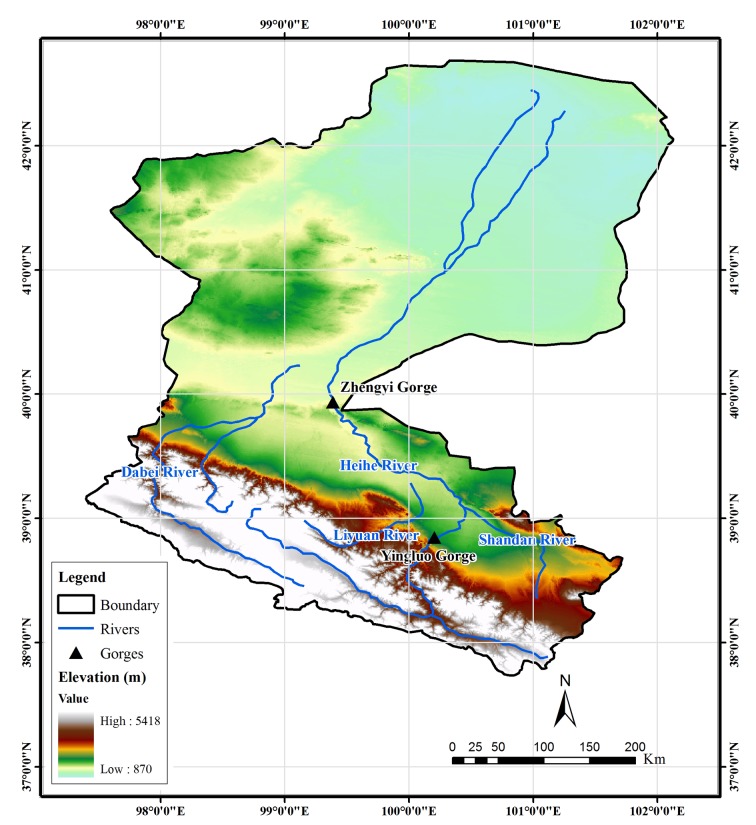
Topography and river system of the Heihe River Basin.